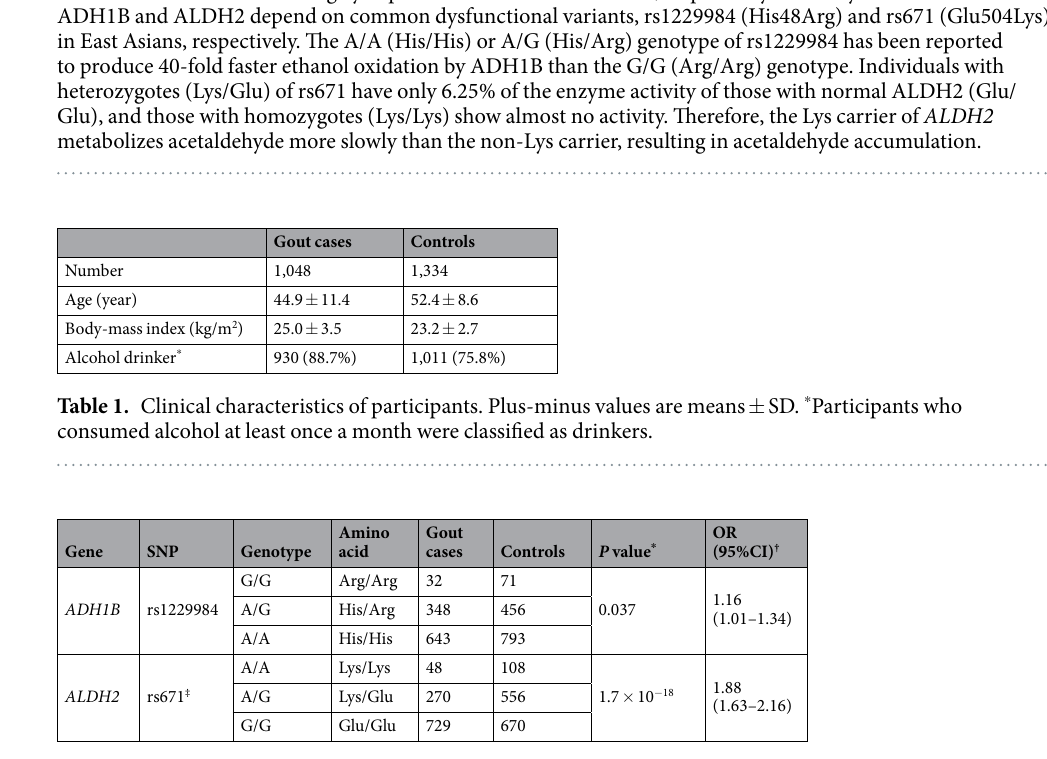
Table S1, A/G (His/Arg) and A/A (His/His) genotypes significantly increase the risk of gout ( P = 0.020 and 7.3 × 10 − 3 ; OR = 1.69 and 1.80, respectively) as compared with the G/G (Arg/Arg) genotype; however, there is no significant difference in effect sizes on gout between A/G (His/Arg) and A/A (His/His) genotypes ( P = 0.51), and the OR is close to 1.00 (OR = 0.94; 95% CI: 0.79–1.12). Based on these results and enzyme activity 13–15 , we